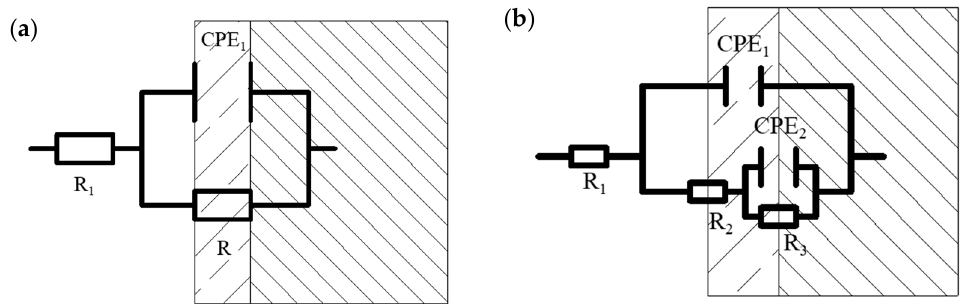
Figure 5. Equivalent circuits for electrochemical impedance spectra analysis: ( a ) equivalent circuit for samples without corrosion production; ( b ) equivalent circuit for samples with corrosion production.